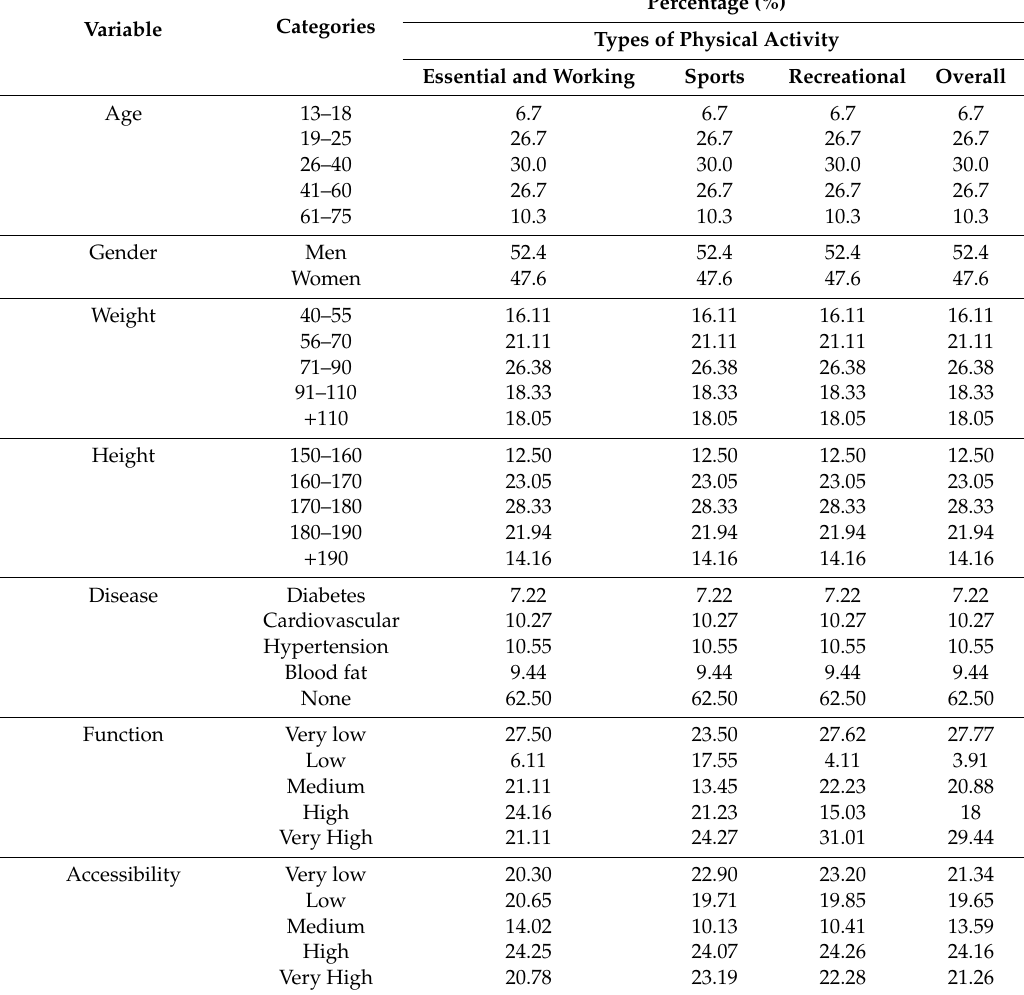
Table 3. General questionnaire questions and